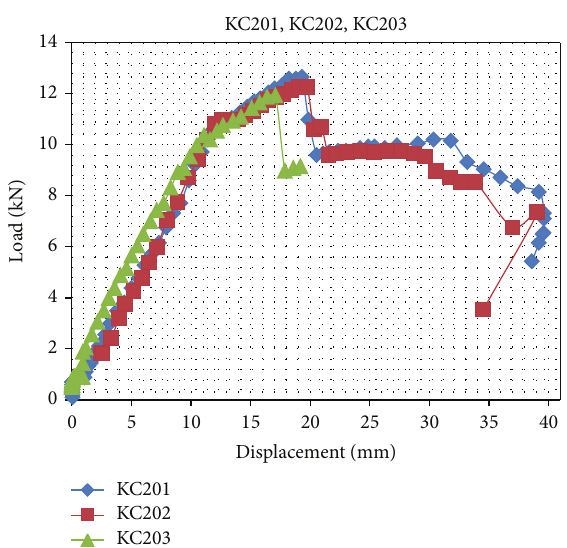
Figure 7: Load-displacement chart of the sample beam strength- ened with CFRP.